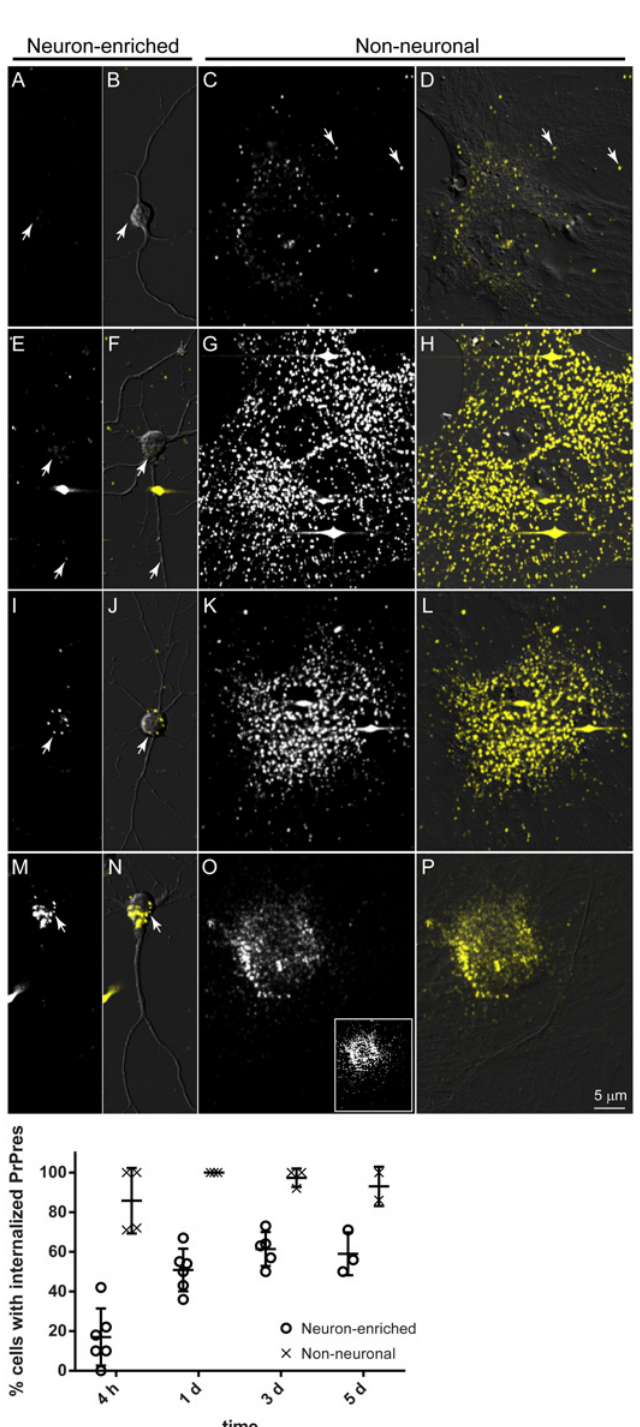
Fig 5. Non-neuronal cells internalize PrPres more efficiently than neurons. Neuron-enriched and non- neuronal primary cultures were incubated with 263K A647 and observed by live cell confocal microscopy at 4 – 6 h (A-D), 1 day (E-H), 3 days (I-L), or 5 days (M-P) post-exposure. After 4 – 6 h of incubation, fluorescent aggregates (arrows) were observed on cell surfaces in both cultures (A and C). The percentage of cells with internalized PrPres was significantly higher in non-neuronal cultures at all time points. Progressive accumulation of PrPres within non-neuronal cells necessitated imaging with about two-fold lower laser intensity at 5 dpe (panel O) to prevent detector saturation. Inset in panel O represents image of same field of